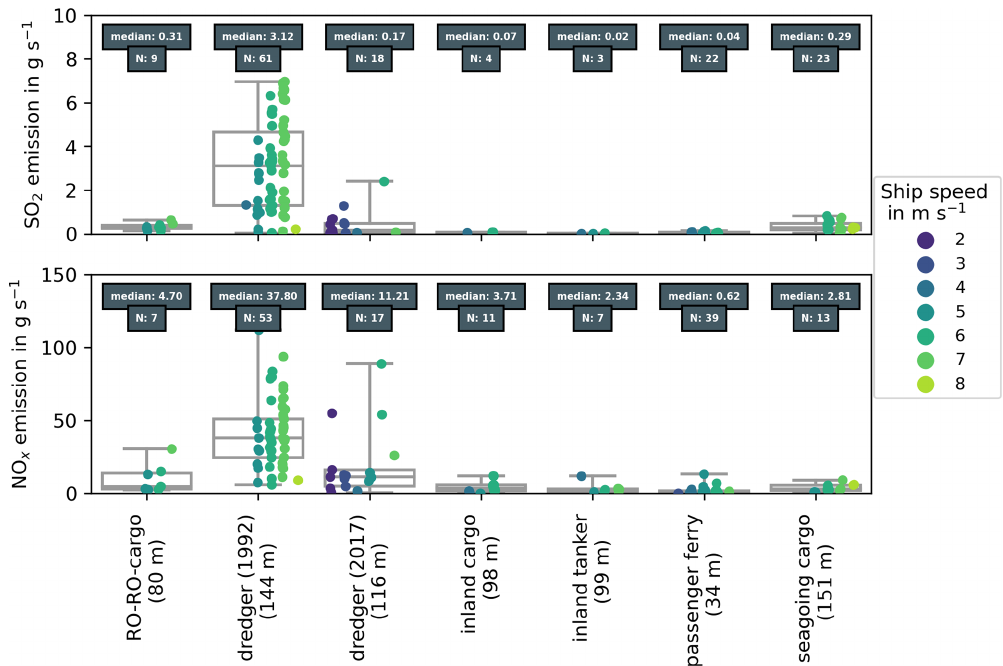
Figure 6. Box plot of SO 2 and NO x emission rates in grams per second for individual ships; their respective length is given in brackets. Boxes indicate the 25th and 75th percentile, the line in the middle is the median, and the bars show minimum and maximum values. Dots show individual measurements and are colour coded by corresponding ship speed. Dark grey boxes show the median emission rate and total number of observations for this ship. Table 6. Comparison of emission rates derived from emission factors of other studies for two different fuel consumptions. The lower value is for a fuel consumption of 165kgh − 1 , which is typical for inland ships. The upper value is for a fuel consumption of 2000kgh − 1 , which is roughly the fuel consumption of a large container ship (14000TEU carrying capacity) at a speed of 7ms − 1 (Notteboom and Vernimmen,